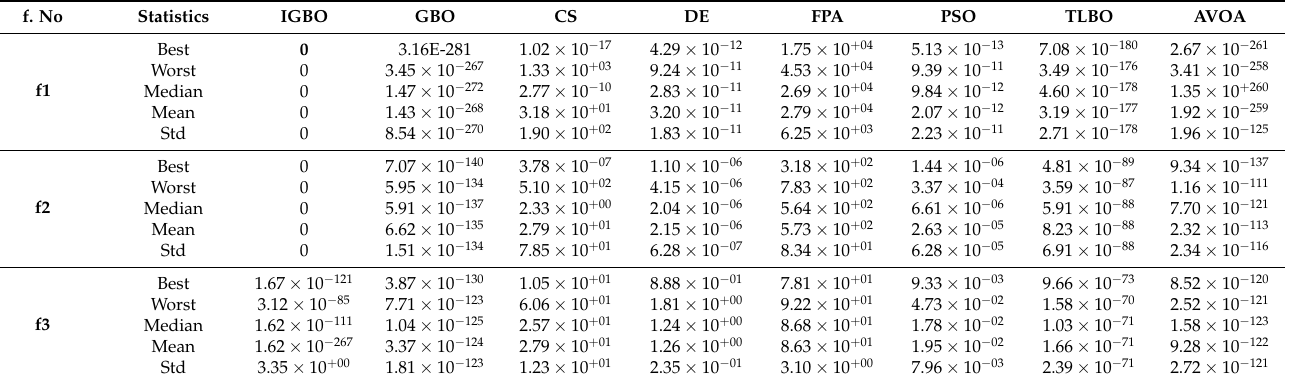
Table 4. Unimodal Benchmark Functions Results.